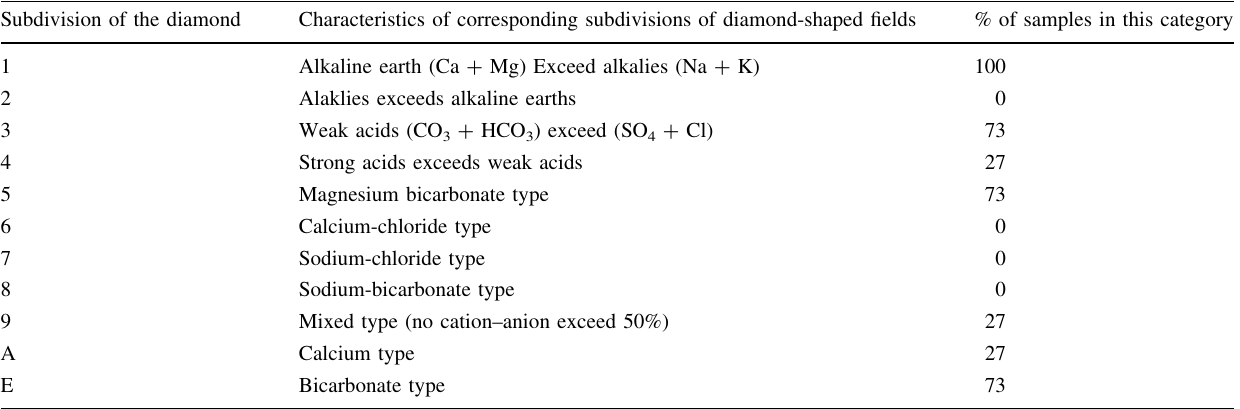
Table 7 Characterization of groundwater resources of the study area sampled during 2012–2013 according to the Piper trilinear diagram Subdivision of the diamond Characteristics of corresponding subdivisions of diamond-shaped fields